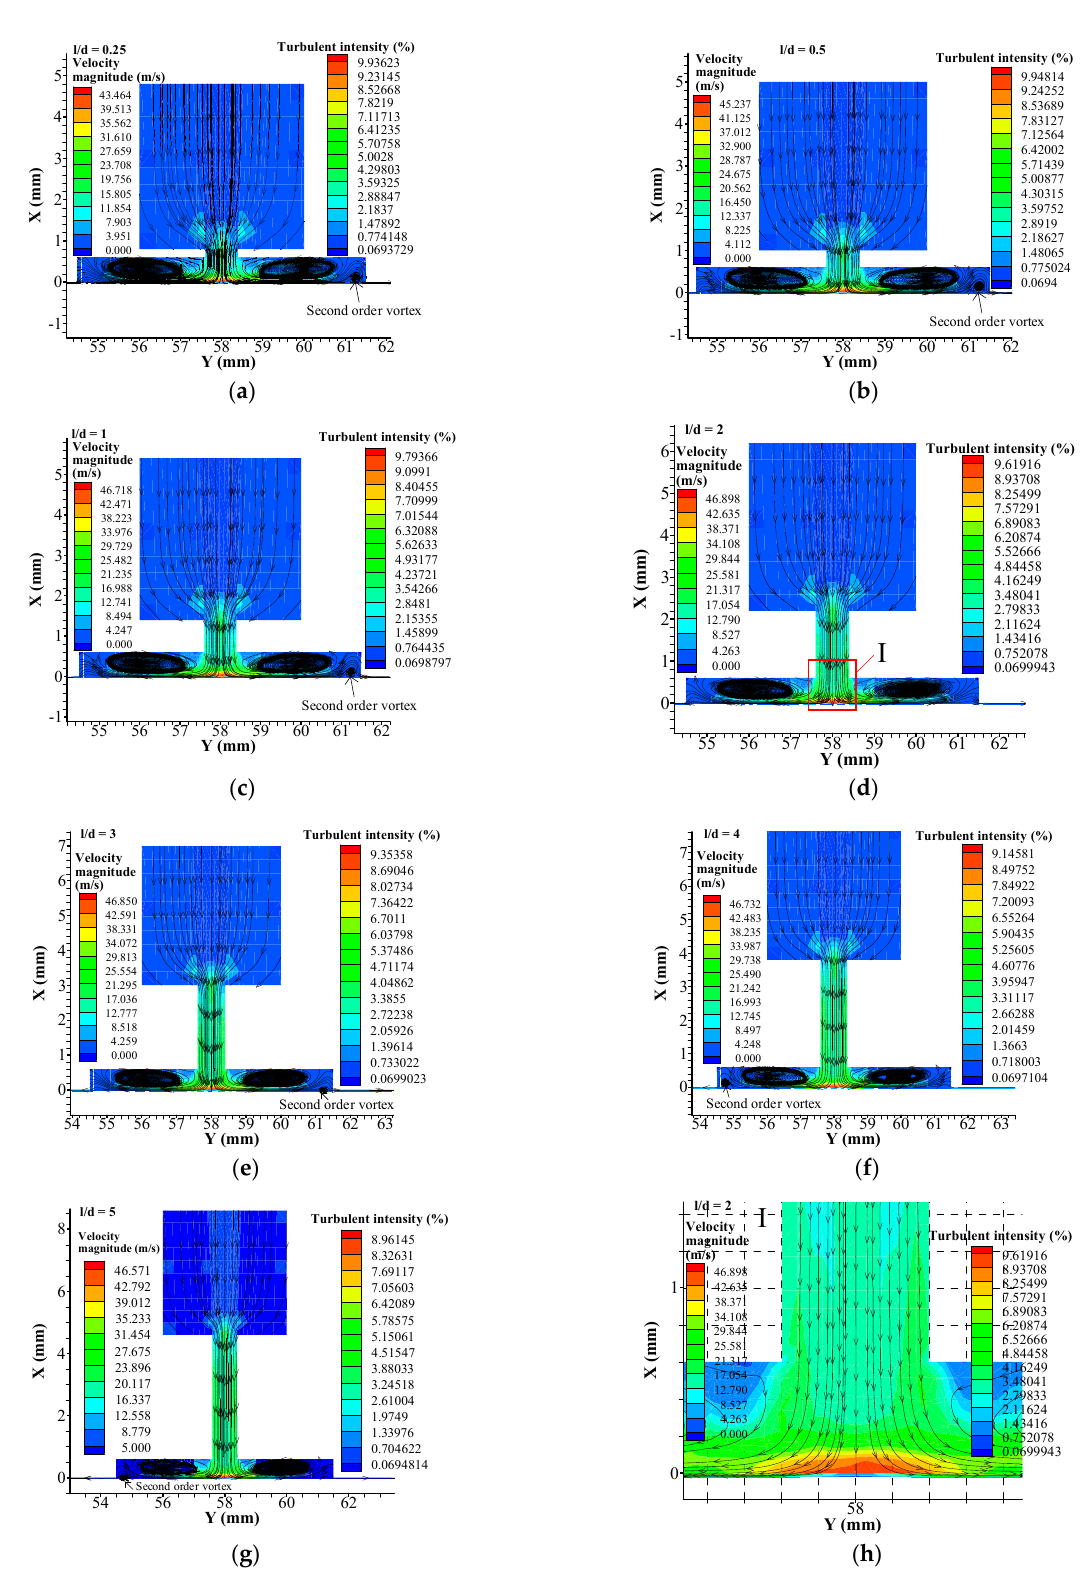
Figure 12. Streamlines and turbulent intensities contours of orifice longitudinal sections for various OLDRs. ( a ) l / d = 0.25; ( b ) l / d = 0.5; ( c ) l / d = 1; ( d ) l / d = 2; ( e ) l / d = 3; ( f ) l / d = 4; ( g ) l / d = 5; ( h ) local enlarged view of Ⅰ .